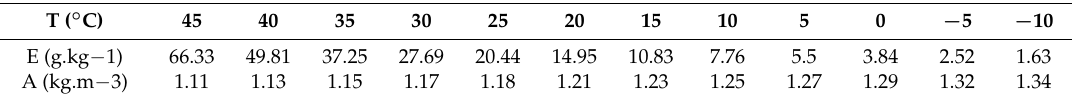
Table 3. Relationships between saturation mixing ratio (E), air density (A), and air temperature (T) (after the literature